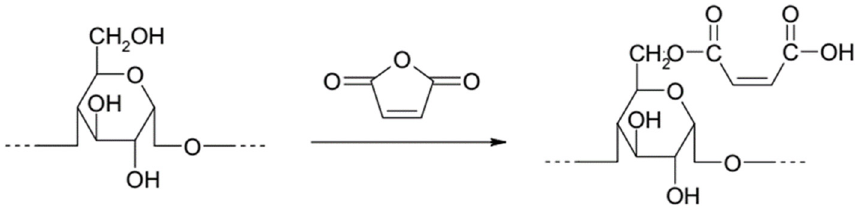
Figure 6. Starch’s esterification reaction with maleic anhydride occurs at the C6 position [21].